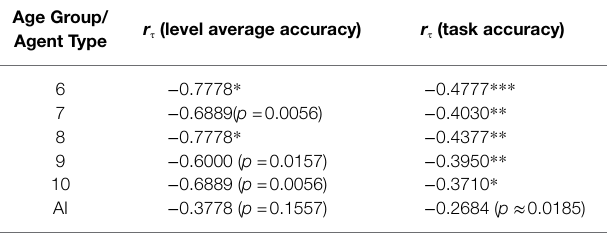
TABLE 5 | Kendall’s Tau by age group/agent type, with Bonferroni correction. Age Group/ Agent